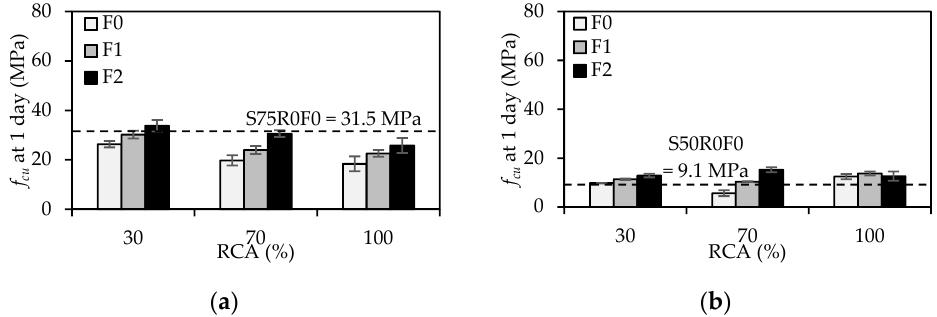
Figure 5. Cubic compressive strength of 1-day alkali-activated slag-fly ash blended concrete mixtures: ( a ) 3:1 slag:fly ash; ( b ) 1:1 slag:fly ash.